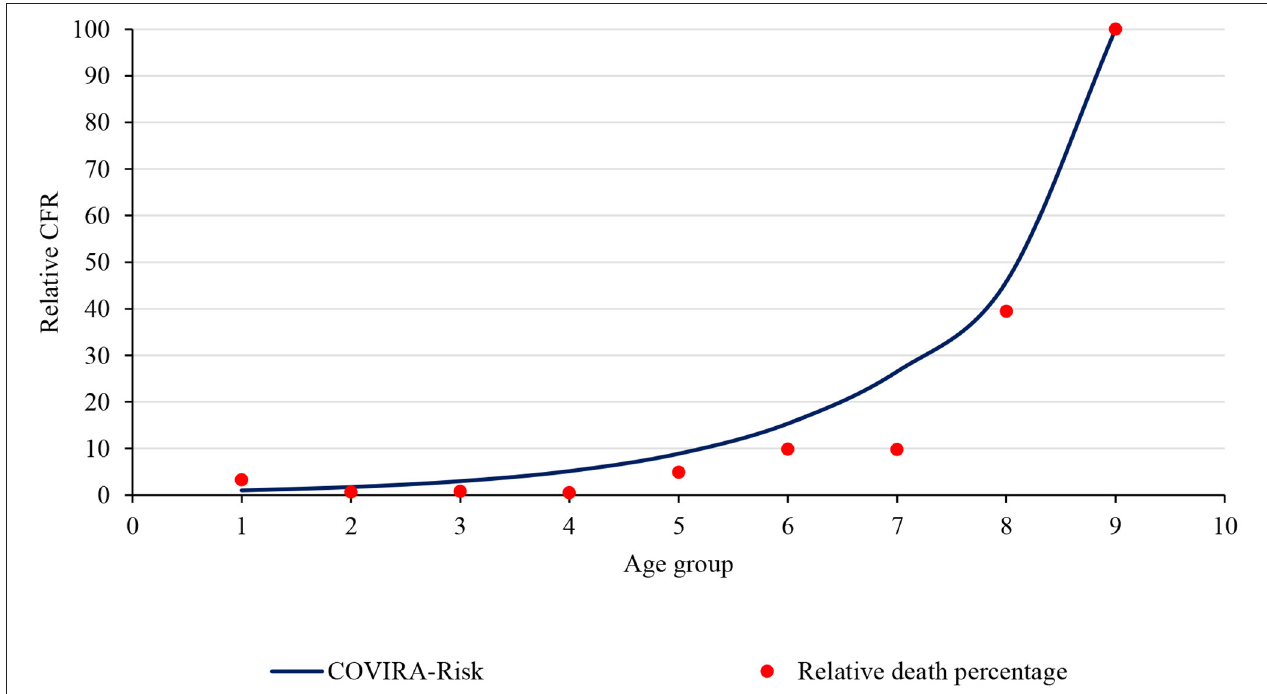
FIGURE 4 | Relative case fatality ratio and comparison with the COVIRA risk